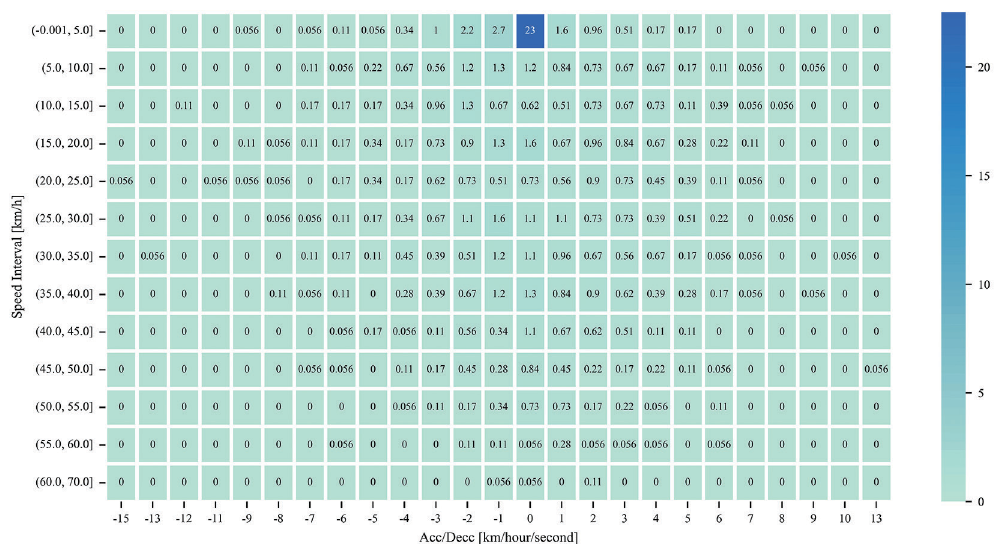
Figure 13. Assessment parameters from basic